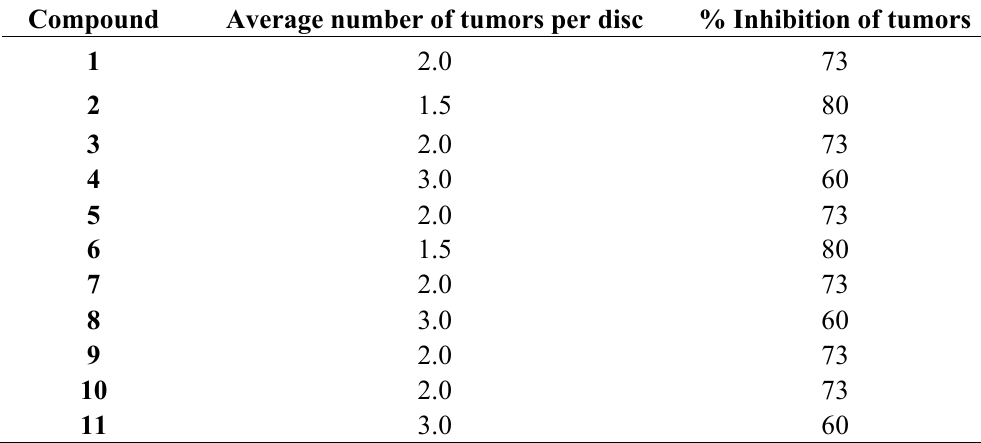
Table 4. Antitumor activity of synthesized